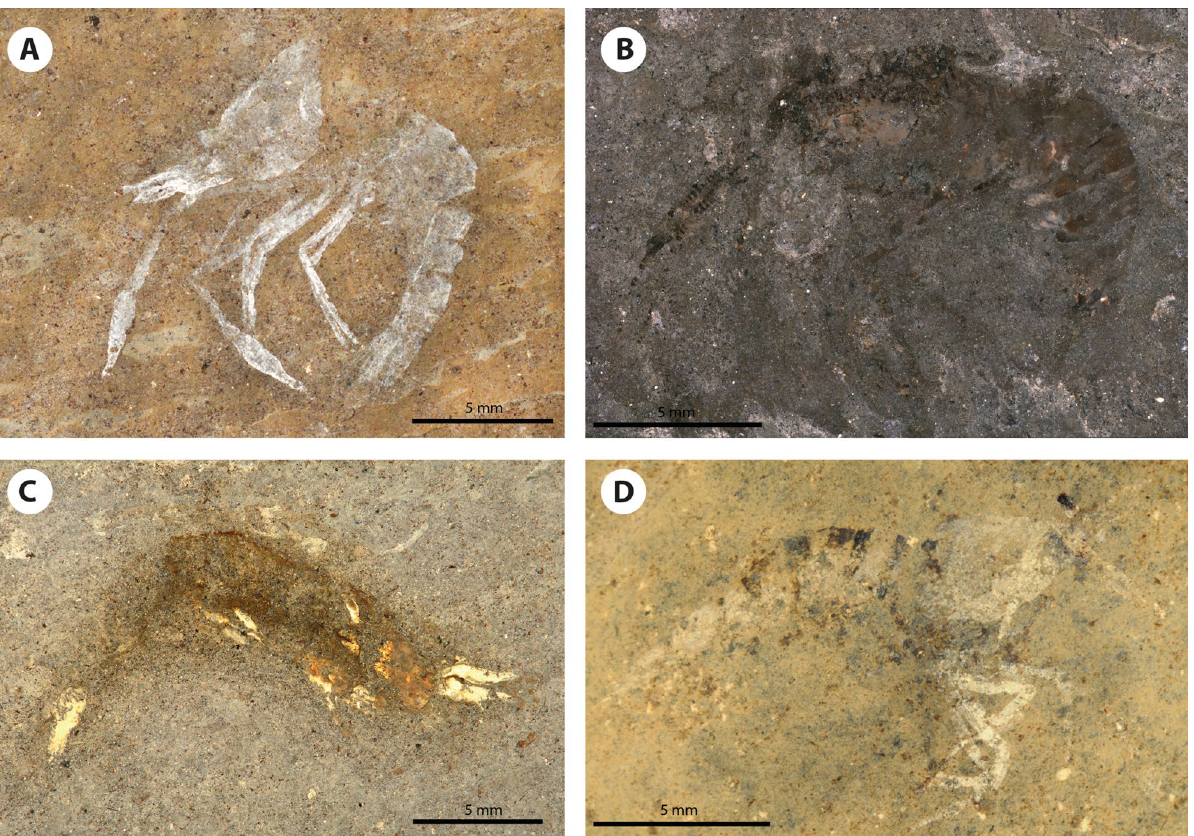
Figure 5. Photographs of the paratypes of Bechleja brevirostris n. sp. ( A ) SF-MeI 13611 A; ( B ) HLMD-Me 13920; ( C ) SF-MeI 16018 A; ( D ) SF-MeI 14640